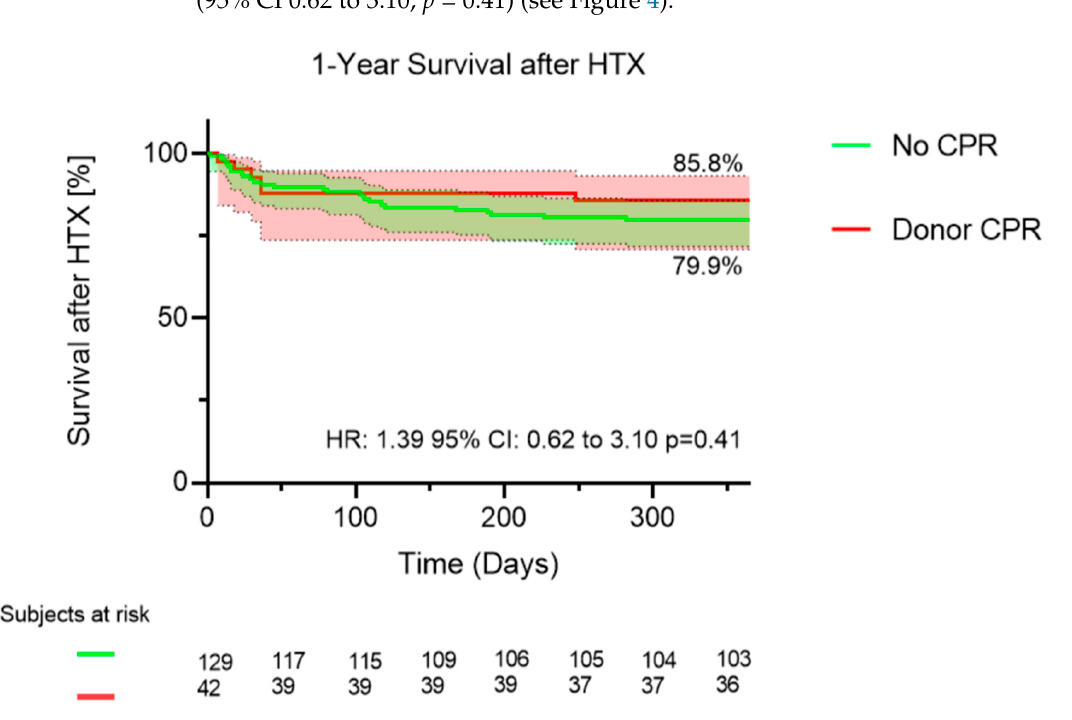
Figure 4. Comparison of survival at one year after heart transplantation between patients who received donor hearts with and without history of cardiopulmonary resuscitation.